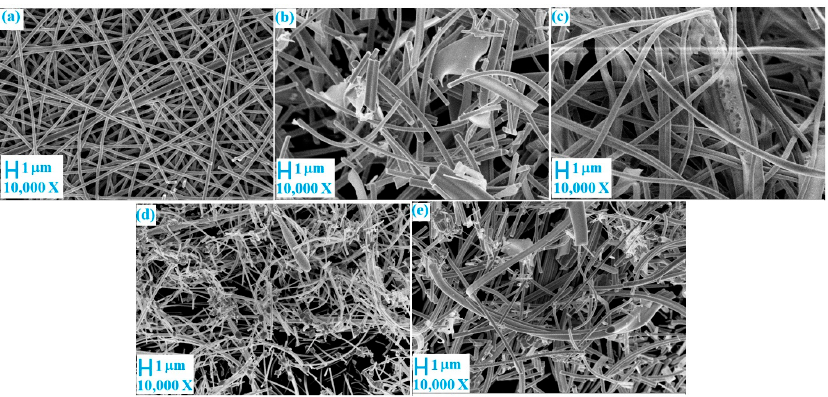
Figure 3. SEM photographs of fibers after annealing: ( a ) 100% TiBALDH, ( b ) 90% TiBALDH, ( c ) 50% TiBALDH, ( d ) 10% TiBALDH, and ( e ) 0% TiBALDH.